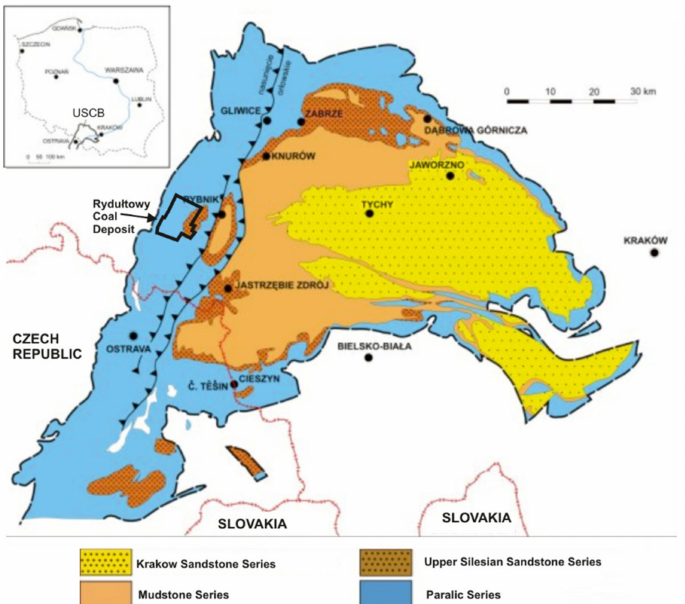
Figure 1. The Rydułtowy coal deposit against the background of the lithology and stratigraphy of the Upper Silesian Coal